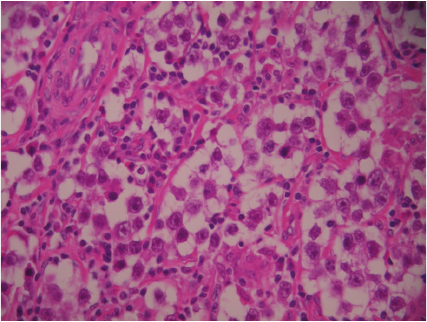
Figure 2: Nests of undifferentiated cells with pale cytoplasm, with a lymphocytic infiltrate typical of classical